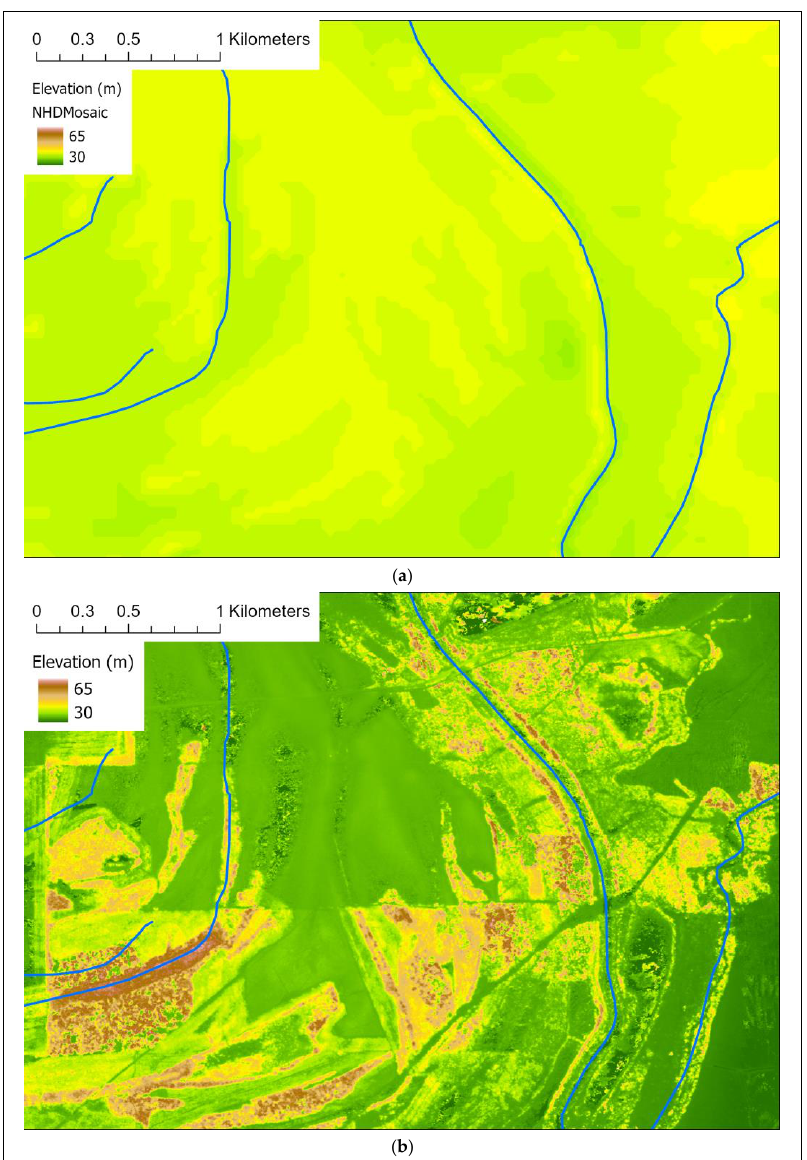
Figure 9. Topographic image from an agricultural area northeast of Greenwood, MS, based on ( a ) NED 30 m digital elevation model and ( b ) 16 cm digital surface model generated from data collected during the Feb. 25, 2019 mission. Blue lines denote water flowlines defined by the National Hydrography Dataset. Note that scales are the same for the two images.